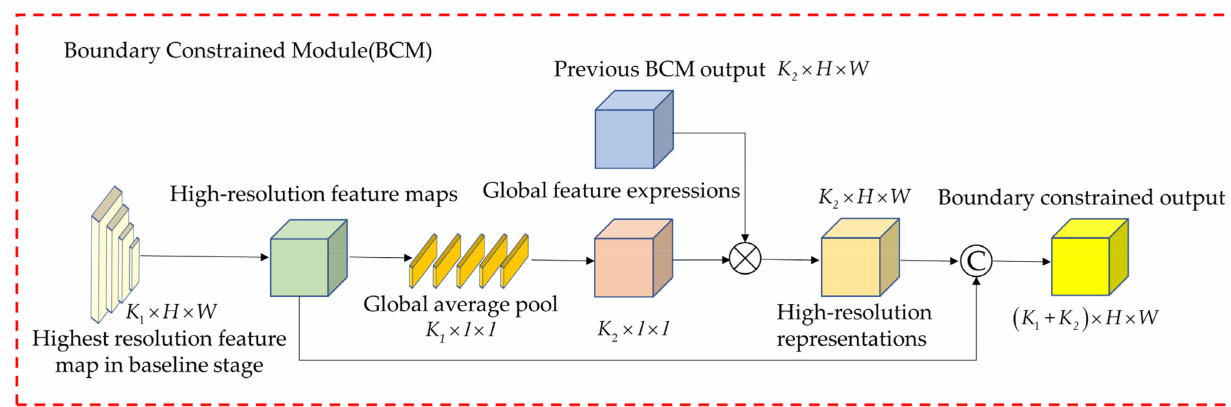
Figure 2. The detailed framework of boundary-constrained